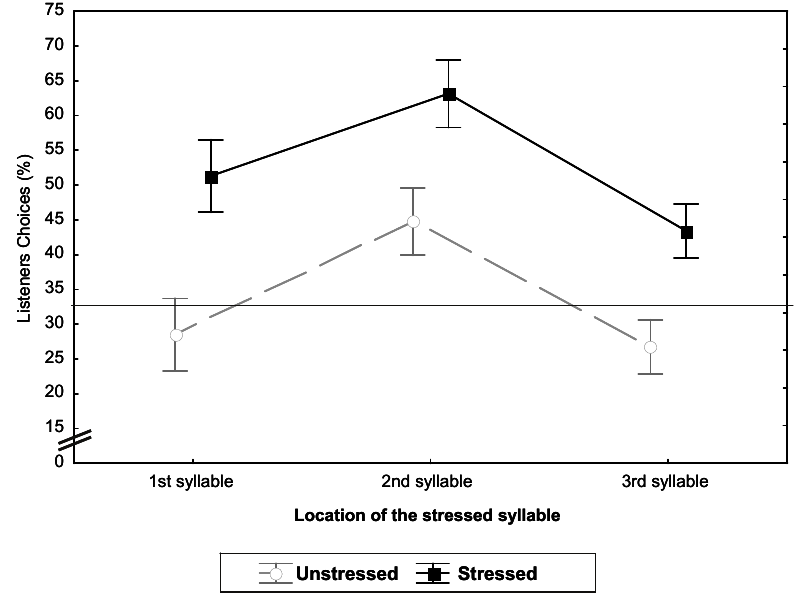
Figure 2: Listeners’ proportion of responses on the three-alternative forced choice stress location task, broken-down by responses (1 st syl; 2 nd syl; 3 rd syl) 23#1), in the two acoustic cue conditions (unstressed vs. stressed) of Experiment 2. Vertical bars denote standard error of the mean. Chance level corresponds to